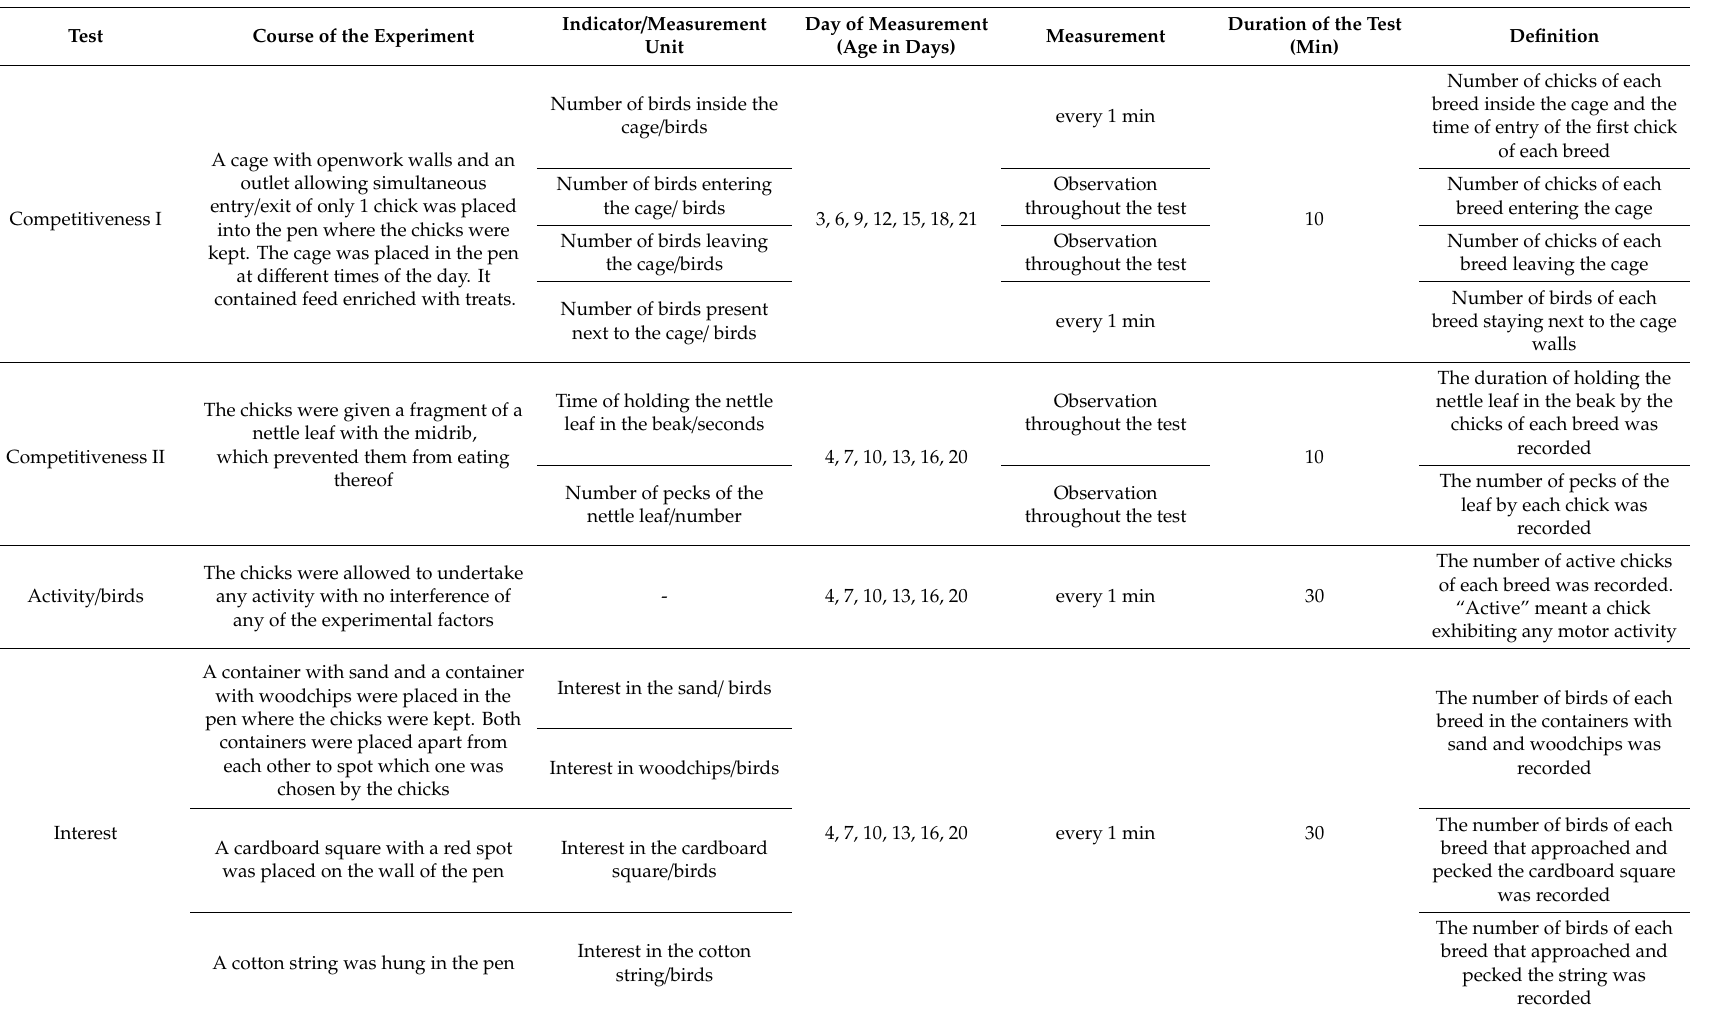
Table 1. Description of the experiment and estimators of chicks’